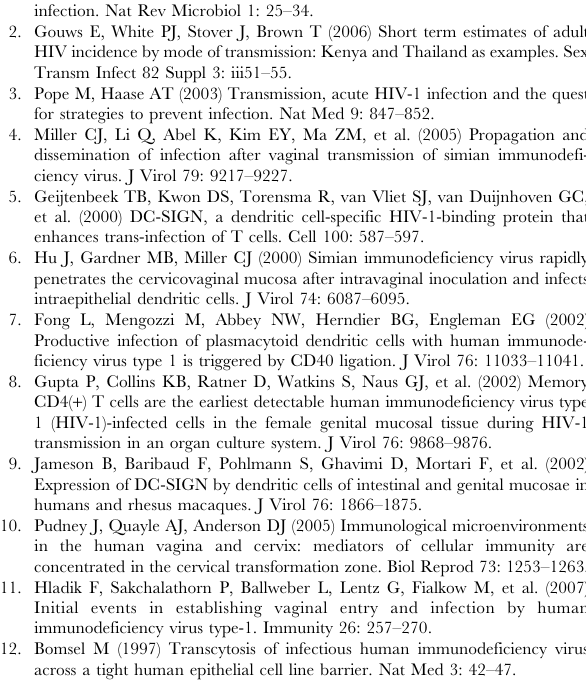
Figure S2 PPAR c and LXR ligand treatment inhibit HIV-1 binding to MDDCs. Immature MDDCs were treated for 48 hours with 100 m M ciglitazone or 1 m M TO-901317 and incubated with HIV-1 ADA for 3–4 hours at 4 u C. Following incubation with virus, cells were washed four times with ice cold PBS and then lysed.